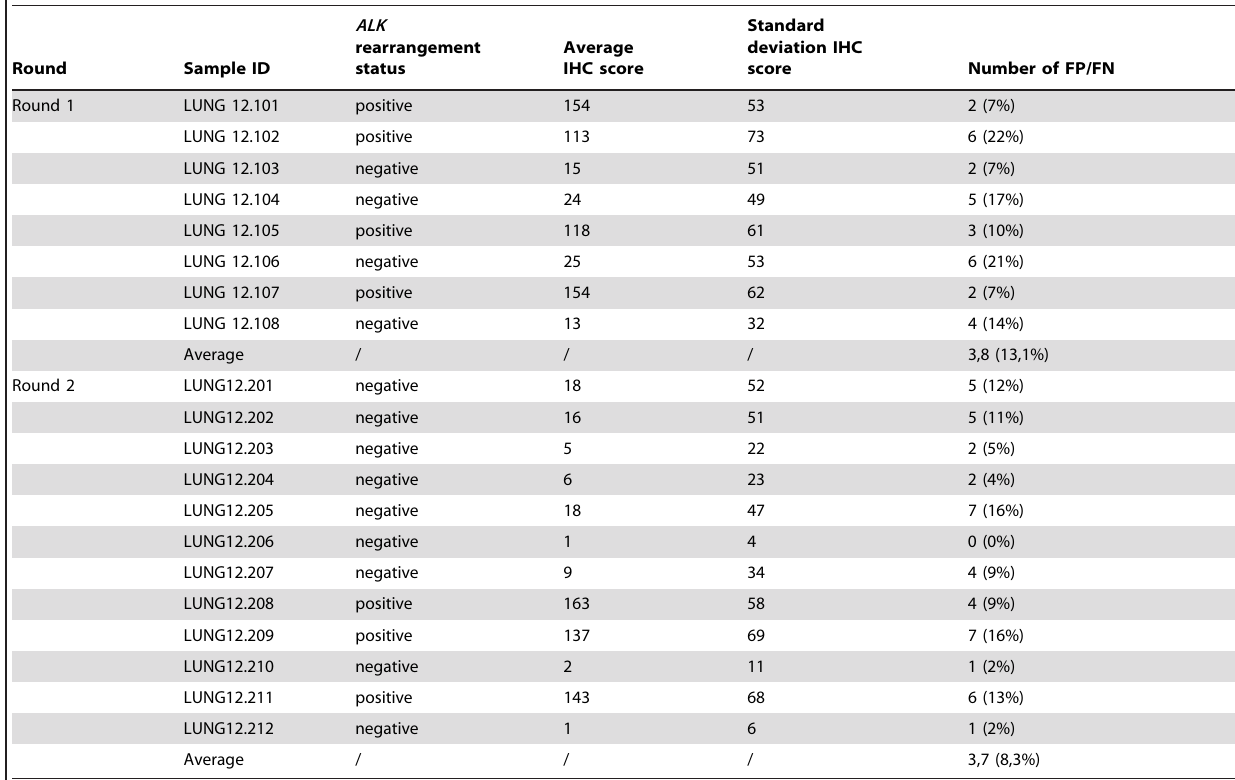
Table 5. ALK IHC results.